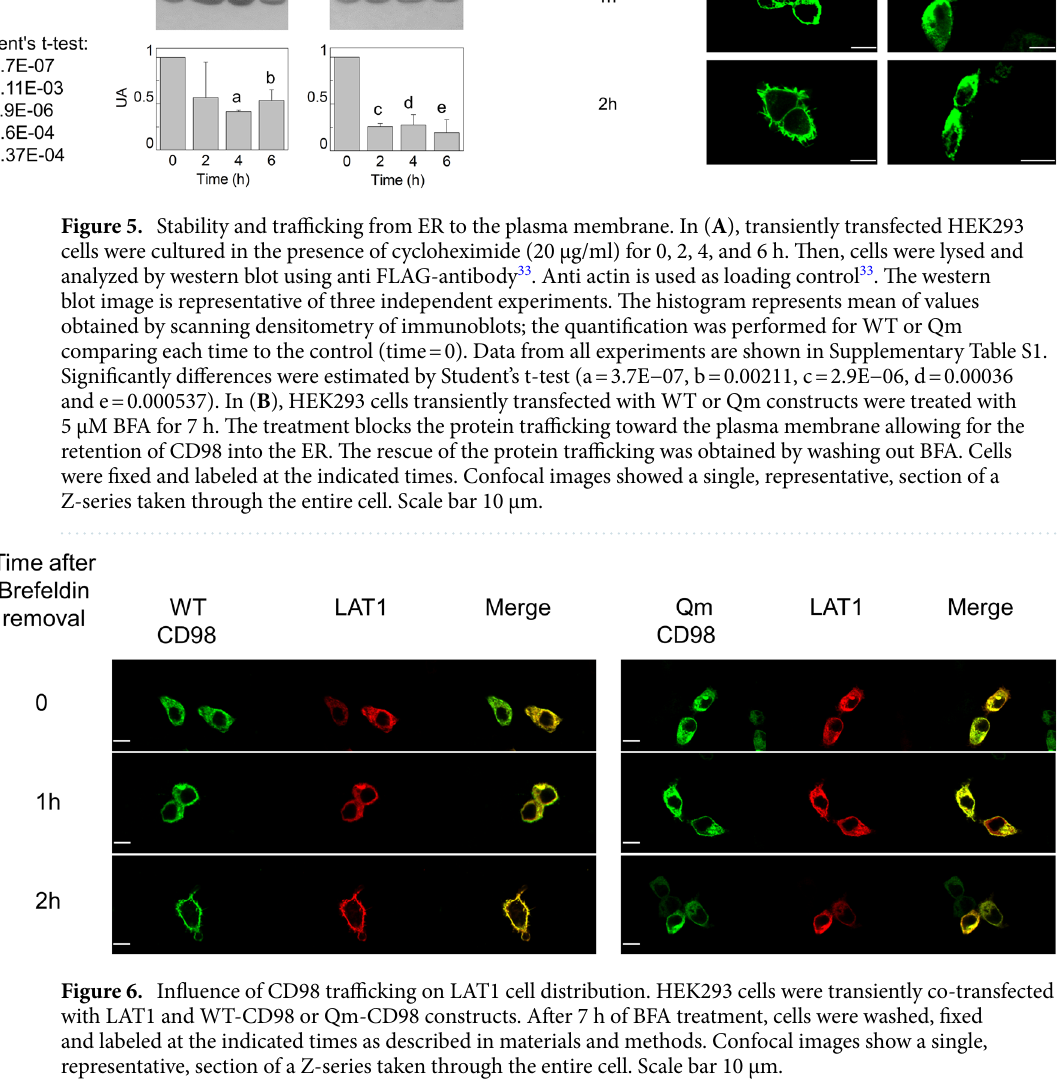
Given that CD98 can form a functional heterodimer with LAT1, the effect of CD98 N-glycosylation on the trafficking of LAT1 towards the plasma membrane was also investigated. HEK293 cells were transiently co-transfected with LAT1 and alternatively with WT-CD98 or Qm-CD98; LAT1 was mainly localised in at the plasma membrane (Fig. S3A). After co-transfection, the treatment with brefeldin was performed to follow protein migration towards the plasma membrane. As shown by Fig. 6 and Fig. S3, LAT1 followed CD98 routing to the plasma membrane. In the case of co-transfection with WT-CD98, after 2 h from the brefeldin removal, LAT1 reached the plasma membrane. On the contrary, in the case of co-transfection with the Qm-CD98, LAT1 was mainly retained in the cytosol. To exclude any influence of the endogenous CD98 on the LAT1 trafficking, HEK293 cells were transfected with the sole LAT1 construct. In this case, the over-expressed LAT1 lost the capability to reach the plasma membrane (Fig. S4). Indeed, the endogenous expression of CD98 is negligible when compared to the overexpressed one (Fig. S5 left panel). Moreover, the co-transfection of CD98 and LAT1 lead to the expression of both the protein in a good and comparable amount (Fig. S5 right panel).